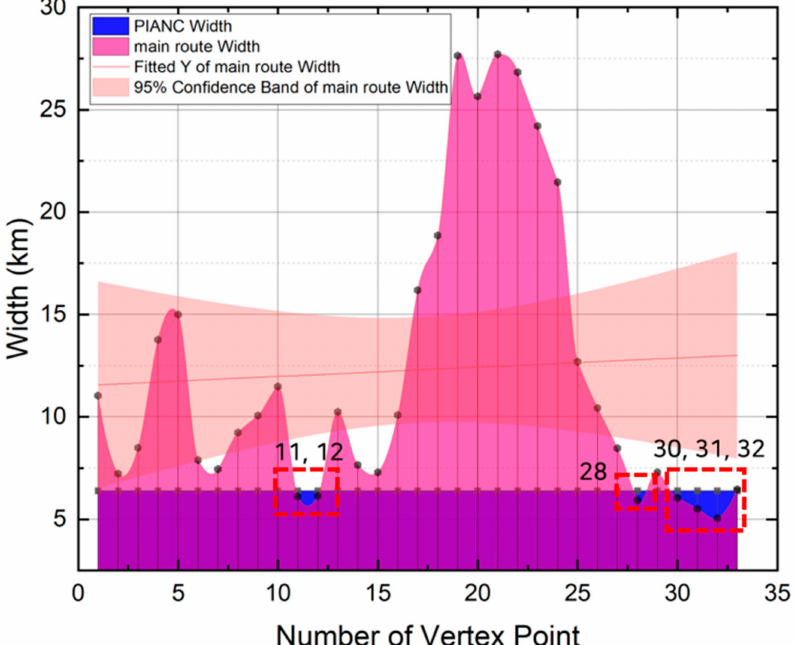
Figure 11. Comparison graph of width value of PIANC and width of the main route and 95% confidence interval graph of the main